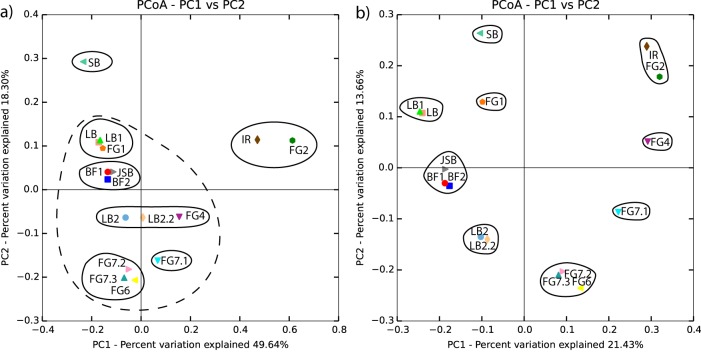
The relative abundance between samples as determined by weighted UniFrac principal-coordinate analysis (PCoA) (a) and the phylogenetic distance determined by unweighted UniFrac PCoA (b). The solid and dashed lines indicate the suggested groupings of the samples.